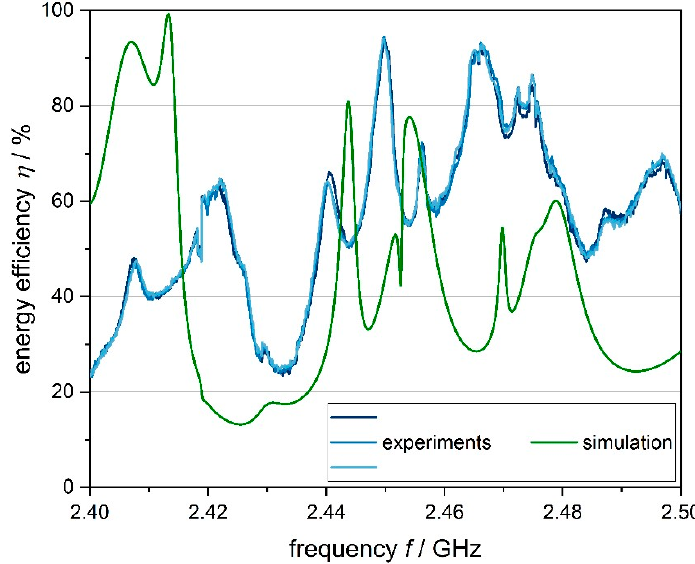
Figure 6. Energy efficiency in the frequency range of 2.4 GHz to 2.5 GHz obtained from the electro- magnetic simulations at a drying state of 0% (green) and experimentally in the laboratory-scale plant in triplicate at 0.5 mbar (blue). The energy efficiency was calculated for the simulation according to Formula (7) and for the experiments according to Formula